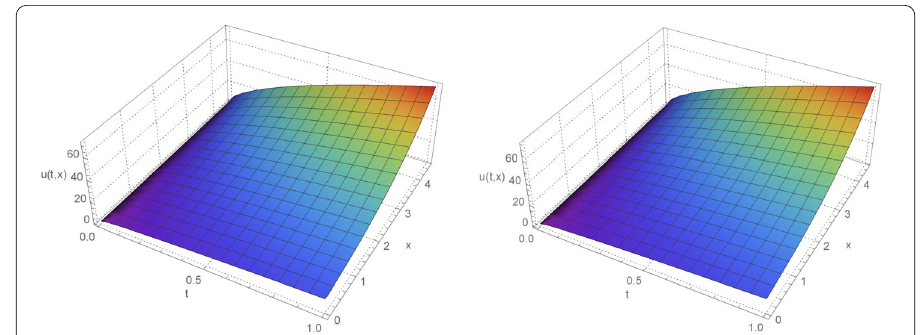
Figure 5 RPSM vs. q-HAM for Case II for U (2) ( t , x ) with β = 0.1, γ = 0.1 and α = 0.35